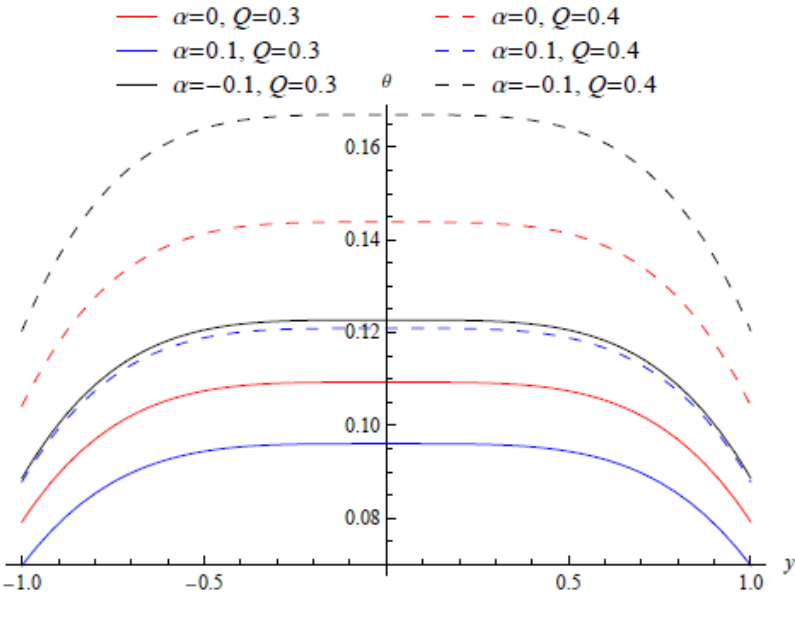
Fig. 12. Effect of , Q  on temperature